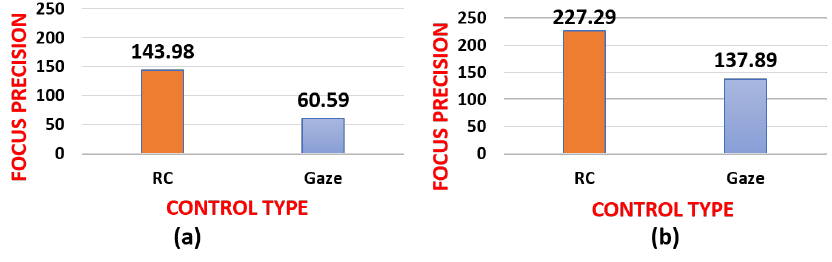
Figure 11. Focus precision (pixels) for ( a ) variation 1, ( b ) variation 2.